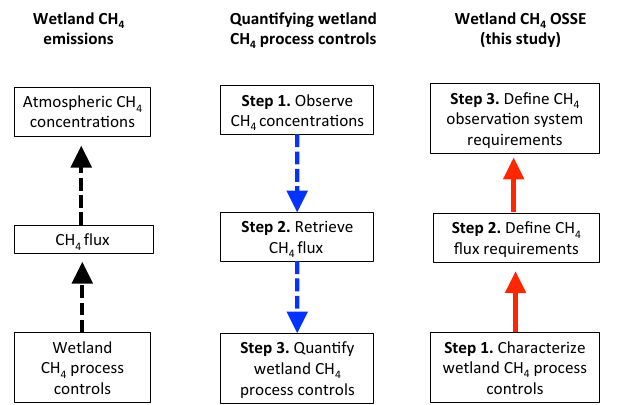
Figure 2. Wetland CH 4 emissions into the atmosphere are regulated by wetland biogeochemical processes (left column). Continental- scale wetland CH 4 process controls can be retrieved by (i) resolving surface CH 4 fluxes from retrieved satellite CH 4 observations and (ii) resolving process parameters from retrieved CH 4 fluxes (middle column). The optimal satellite CH 4 observation requirements are a function of the flux resolution and precision required to resolve wetland CH 4 process controls (right column): OSSE steps 1–3 are described in Sects.